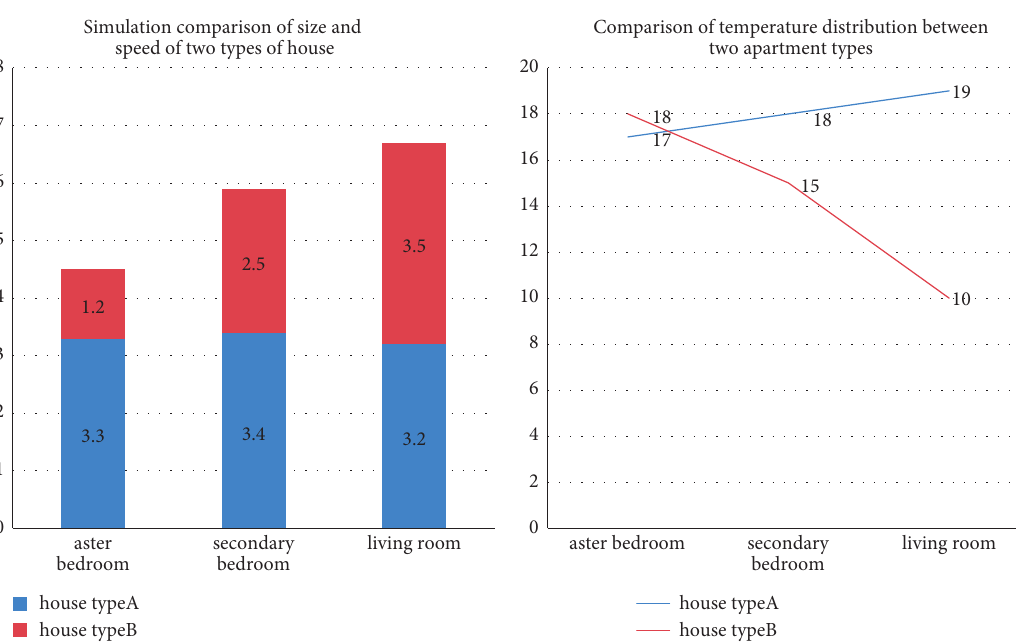
Figure 14: Condition 2: Comparison of speed and temperature distribution of two house